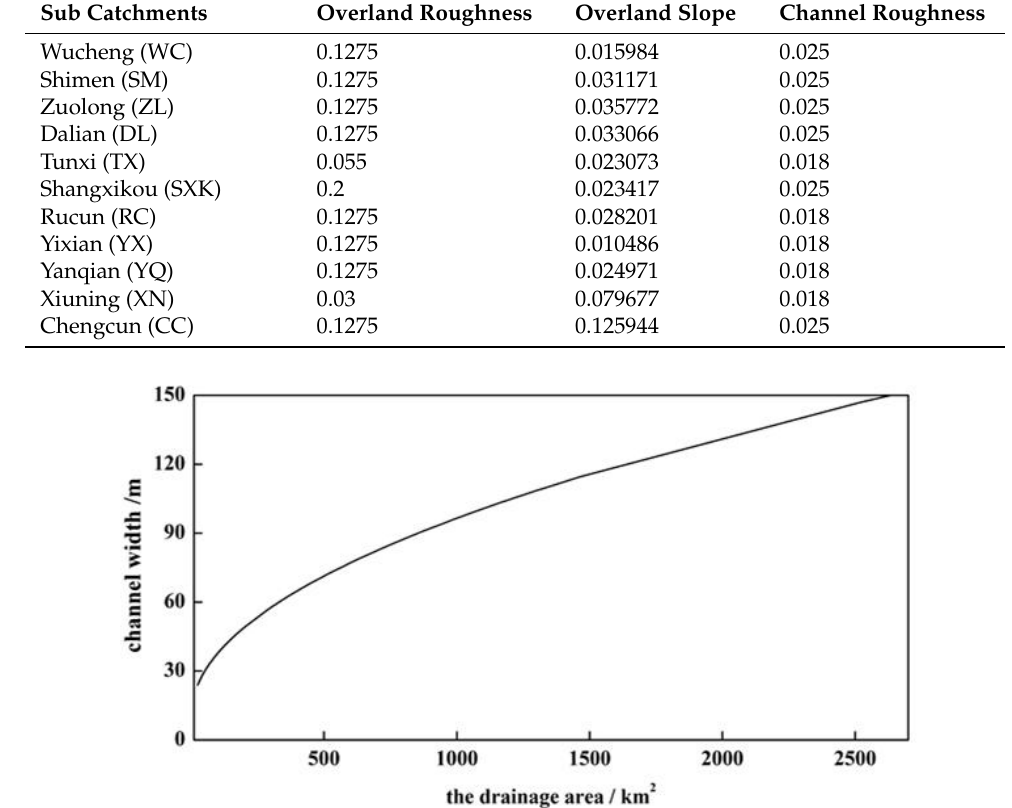
Table 3. Manning’s roughness coefficient values and overland slopes of Tunxi sub catchments.